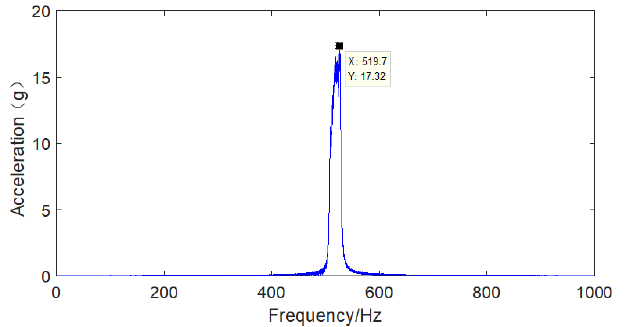
Figure 26. Z r O 2 -PTFE hard coating, 150- μ m-thick galvanized iron clamp-pipeline frequency sweep vibration response.